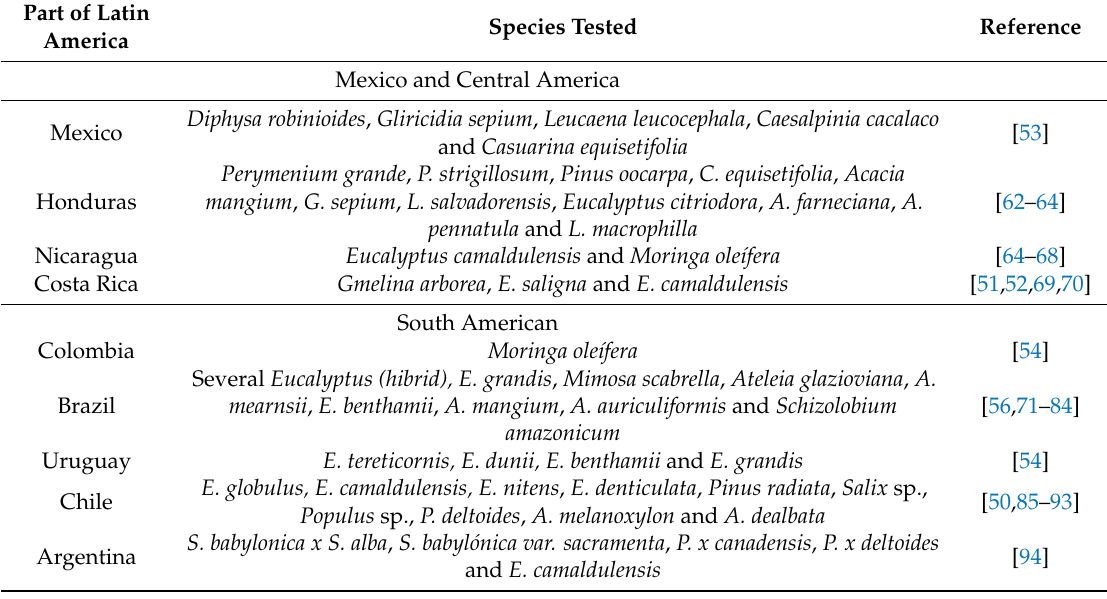
Table 1. Short rotation woody crops in the different countries of Latin